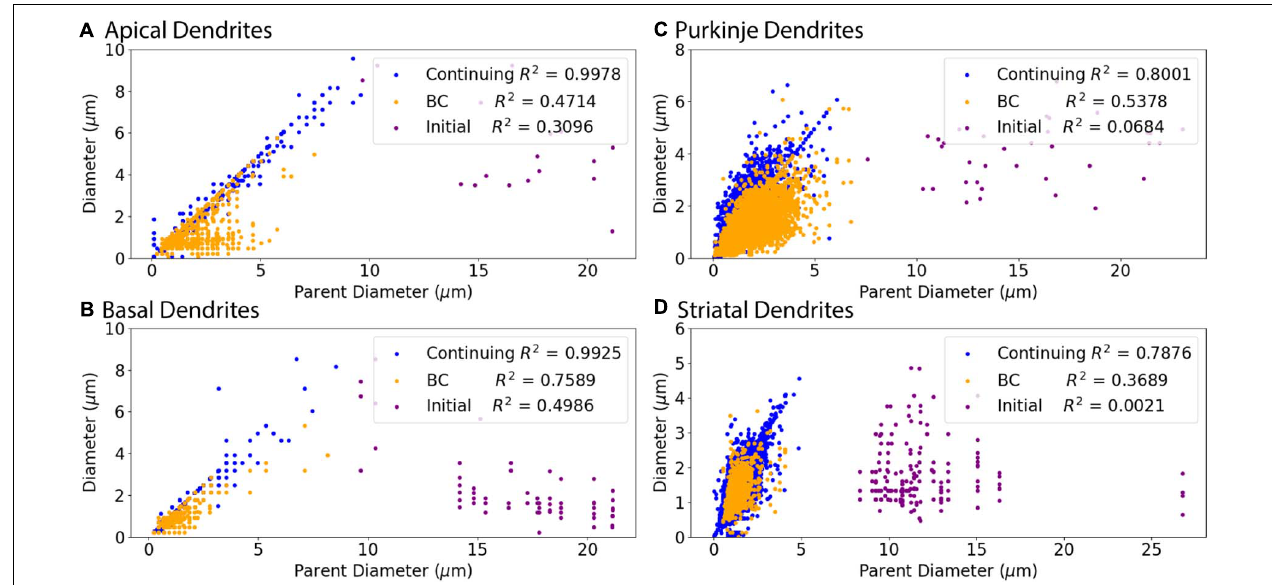
FIGURE 3 | Relationship of Parent Diameter to diameter differs for Initial nodes. Note that the data points are identical to those in Figure 2 , but color coded according to node type instead of archive. R 2 as Pearson’s coefficient of determination for each node type. (A–D) Nodes separated into initial, branching children (BC), and continuing nodes. Branching children and continuing nodes demonstrate strong linear relationship between Parent Diameter and diameter, which is lacking for initial nodes. Node classification explained in Figure 1 . (A) Apical dendrites of hippocampal pyramidal morphologies have 138,536 continuing nodes, 17 initial nodes, and 1,510 branching children nodes. (B) Basal dendrites of hippocampal pyramidal morphologies have 47,899 continuing nodes, 78 initial nodes, and 776 branching children nodes. (C) Cerebellar Purkinje morphologies have 66,376 continuing nodes, 36 initial nodes, and 13,200 branching children nodes. (D) Striatal SPN morphologies have 110,455 continuing nodes, 196 initial nodes, and 1,784 branching children